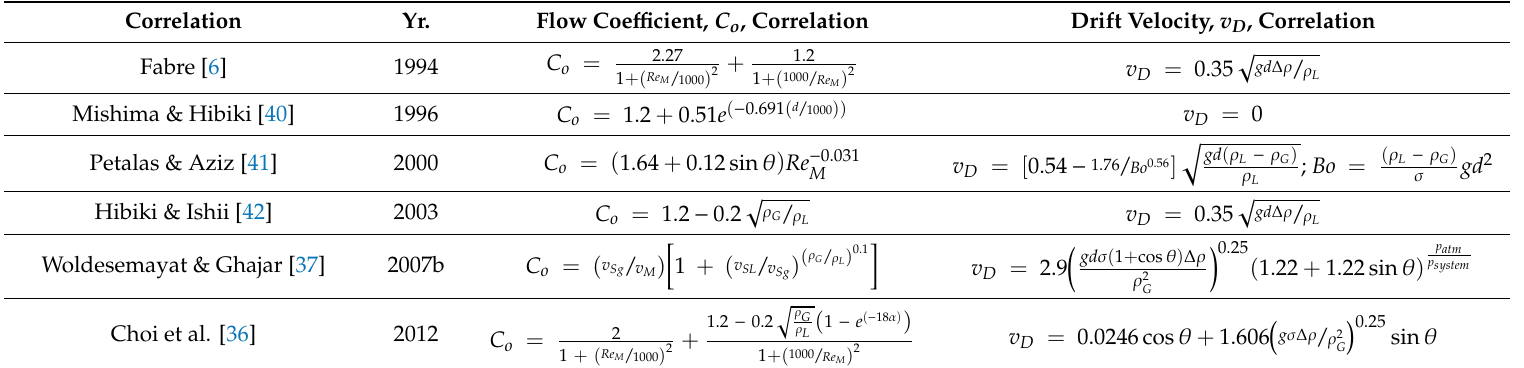
Table 2. Summary of translational velocity, v T ,